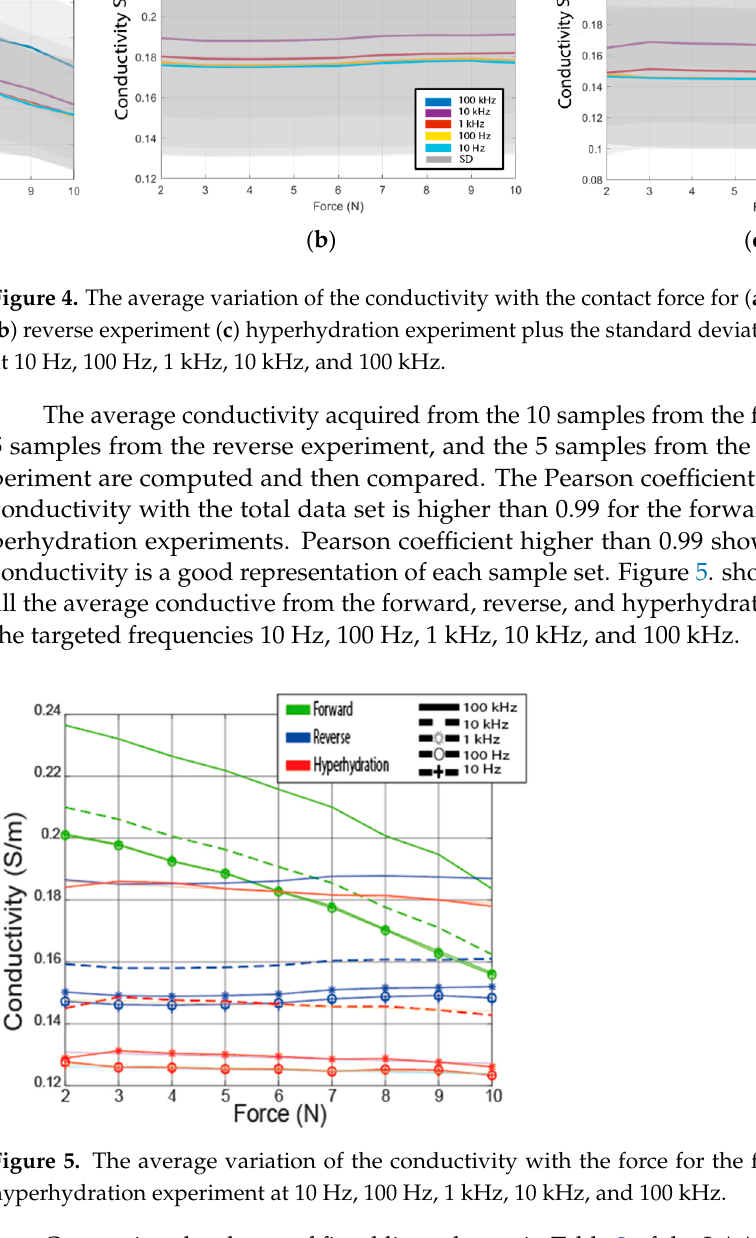
Figure 5. The average variation of the conductivity with the force for the forward, reverse, and hyperhydration experiment at 10 Hz, 100 Hz, 1 kHz, 10 kHz, and 100 kHz. Table 4. p -values from the two tests conducted to assess the significance of the variation between the forward experiment, the reverse, and the hyperhydration experiment.